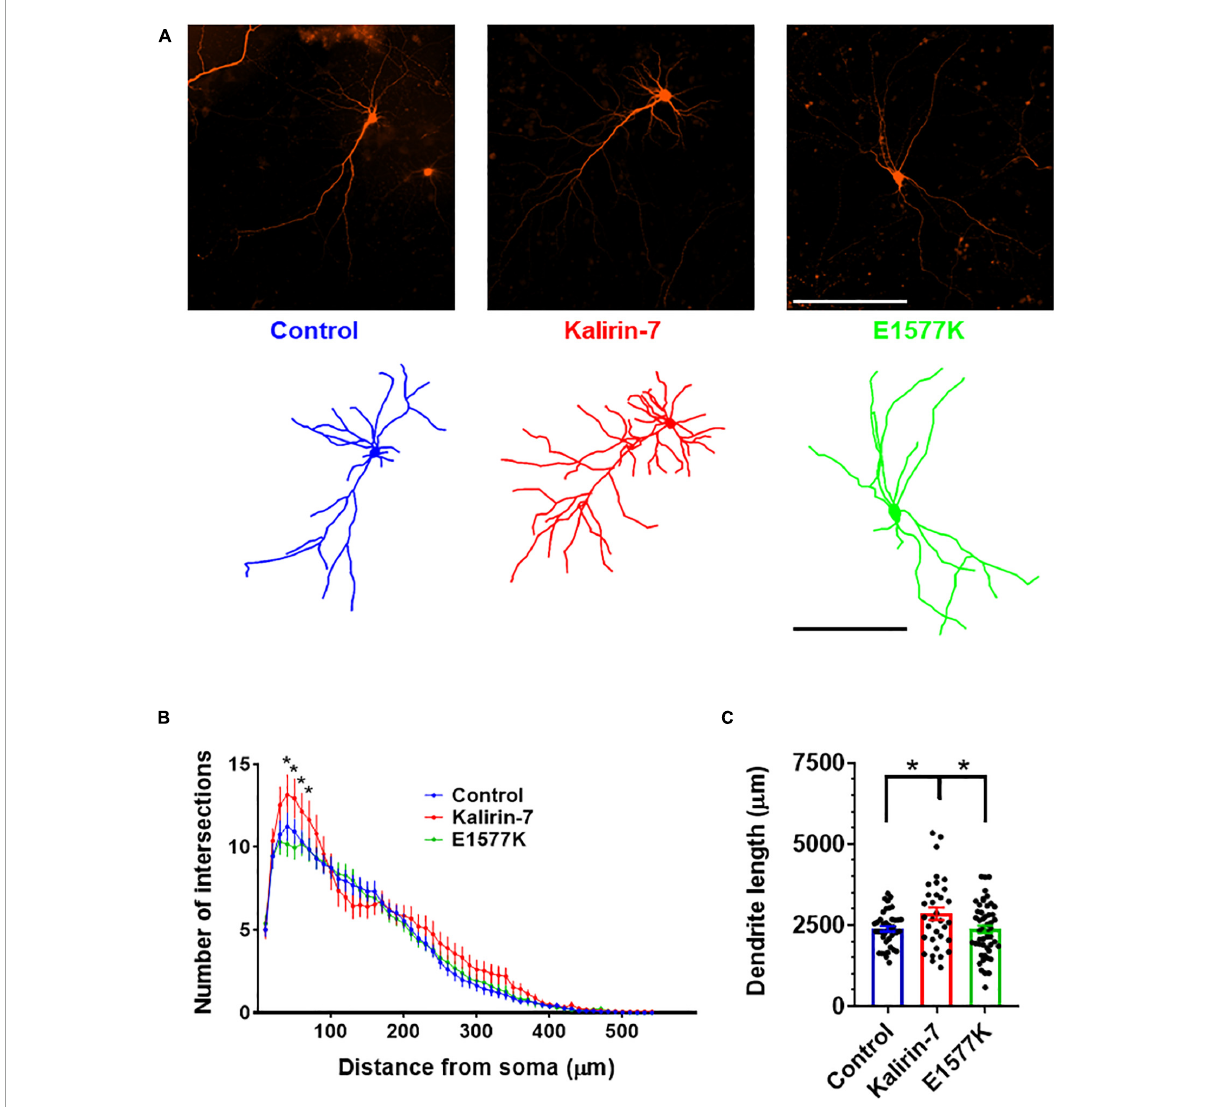
FIGURE2 E1577K is deficient in driving dendritic arborization. (A) Representative images (Top) and dendritic traces of control (mCherry), Kalirin-7 and Kalirin-7-E1577K (E1577K) transfected rat cultured cortical neurons. Scale bar -200 µ m. (B) Sholl analysis of dendritic arbors of indicated conditions. (C) Average total length of dendritic arbors of indicated conditions. Data points represent average ± SEM, * p < 0.05. n = 10–15 neurons per replicate, N =